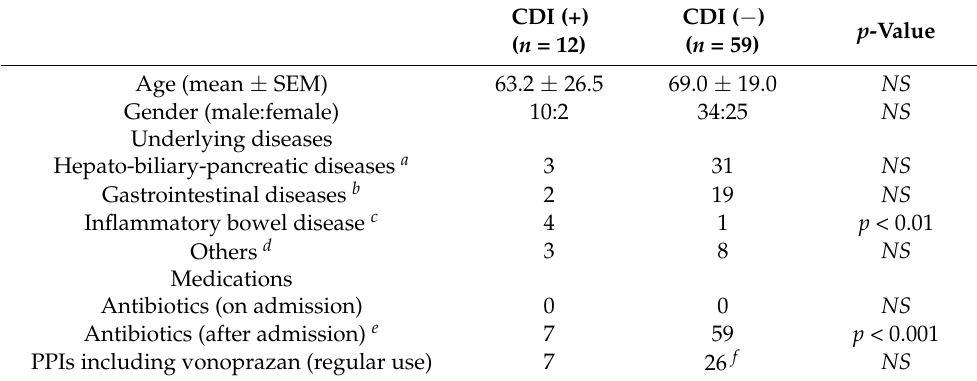
Table 1. Characteristics of enrolled patients with and without Clostridium difficile infection (CDI). CDI